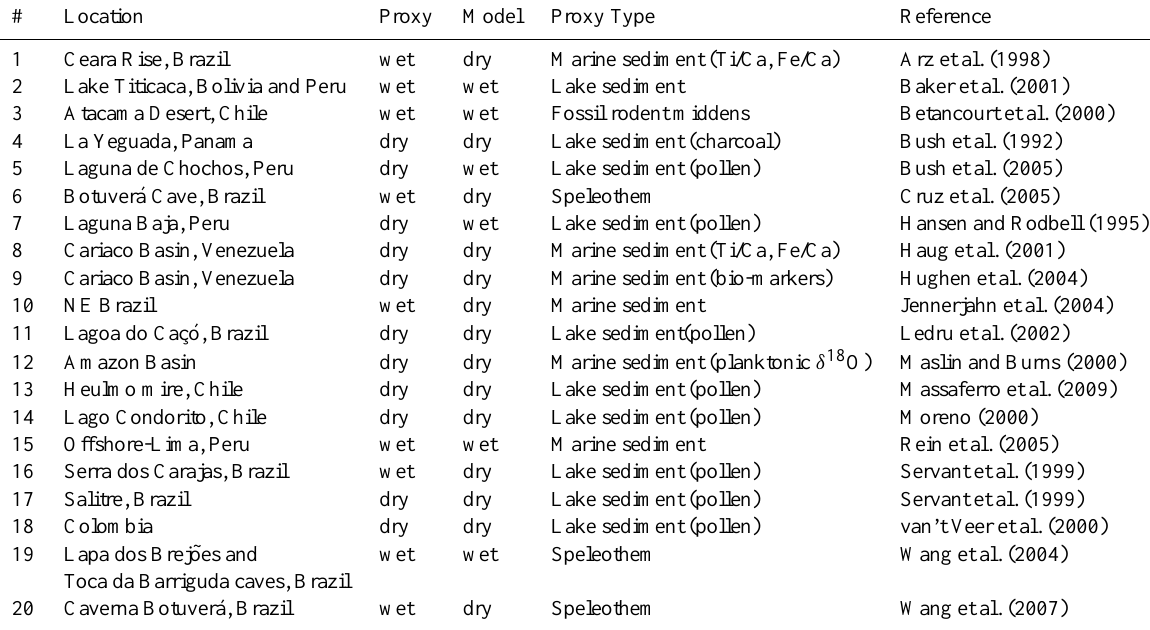
Table 3. List of the paleoclimate reconstruction studies of precipitation change in and around South America during the Younger Dryas event, as used in the compilation given in Fig. 11. Reconstructed anomalies during Younger Dryas are given in comparison with our model results from the experiment 1.0NA. A wide range of climate proxies are used in these reconstructions including, marine sediments, lake sediments, ice cores and speleothems. Pollen records as written in parenthesis are indicative of a change in the vegetation. These are shown in the figure as squares to distinguish from the rest of the proxies (circles).